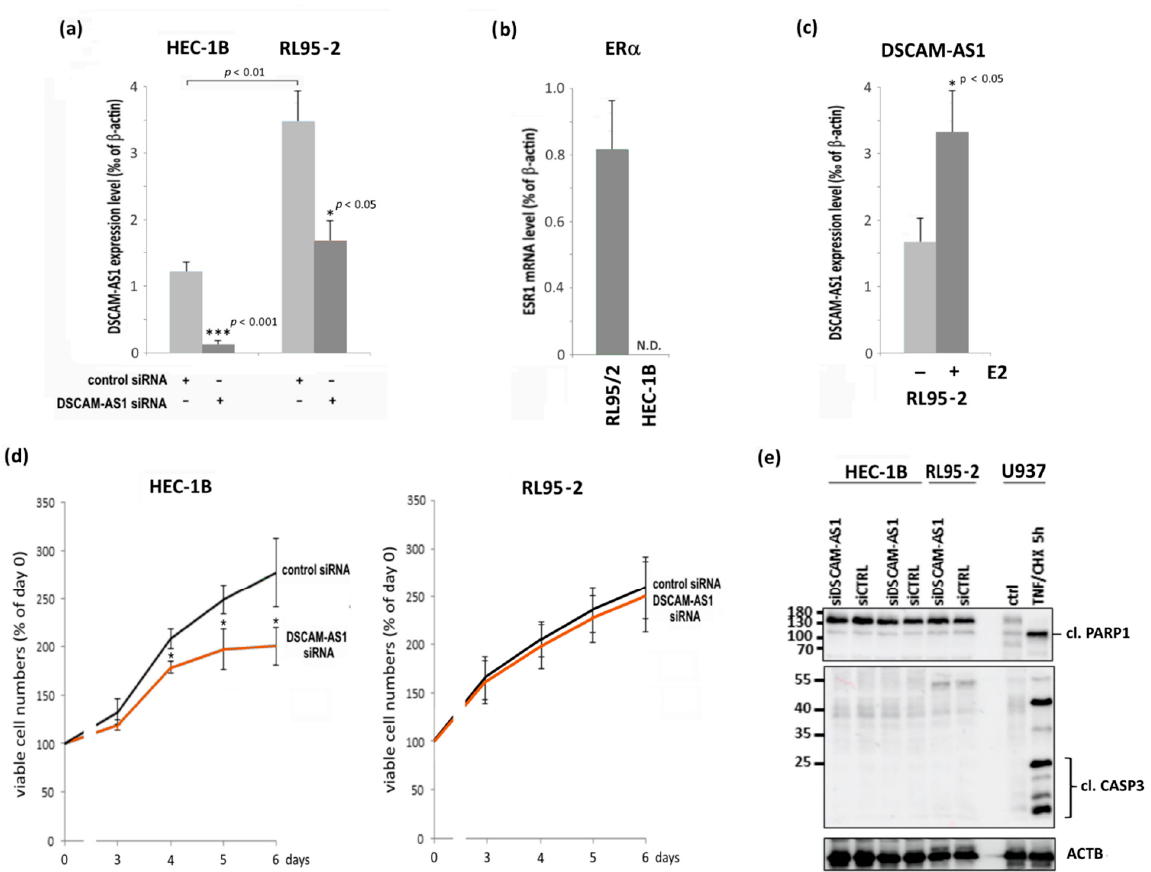
Figure 2. Effects of a knockdown of DSCAM-AS1 expression by means of siRNA transfection. ( a ) HEC-1B and RL95-2 endometrial adenocarcinoma cells were transfected with 60 nM negative control siRNA or the same amounts of siRNAs specific for DSCAM-AS1. A total of 96h after transfection, total RNA was isolated, and cDNA was subjected to RT-qPCR analysis as described in the methods section. DSCAM-AS1 expression levels were normalized to ACTB expression ( Δ CT). * p < 0.05, *** p < 0.001 vs. negative control siRNA ( n = 3). ( b ) RT-qPCR analysis of ER α (ESR1) expression in the indicated cell lines. ESR1 transcript levels were normalized to ACTB expression. Knockdown was less efficient in RL95-2 cells due to its positive ER α status (see Discussion section). N.D. = not detectable ( n = 3). ( c ) Effect of E2 (17 β -estradiol, 3 nM) on DSCAM-AS1 expression in RL95-2 cells. Cells were treated with vehicle or E2 for 48 h and the isolated RNA was subjected to RT-qPCR analysis. * p < 0.01 vs. vehicle. ( d ) Growth of the indicated endometrial cancer cell lines after transfection with DSCAM-AS1-specific siRNA. Cells were transfected with 60 nM of negative control siRNA or DSCAM-AS1 siRNA, and relative numbers of viable cells were measured 3, 4, 5 and 6 days after transfection by means of the Cell Titer Blue assay (Promega) as described in the methods section. * p < 0.05 vs. control siRNA ( n = 4). ( e ) Western blot (WB) analysis for detection of PARP1- and caspase 3-cleavage (cl.) for determination of cellular apoptosis. As a positive control, U937 cells were treated with a combination of TNF α and cycloheximide (CHX). WB analysis was performed as described in the methods